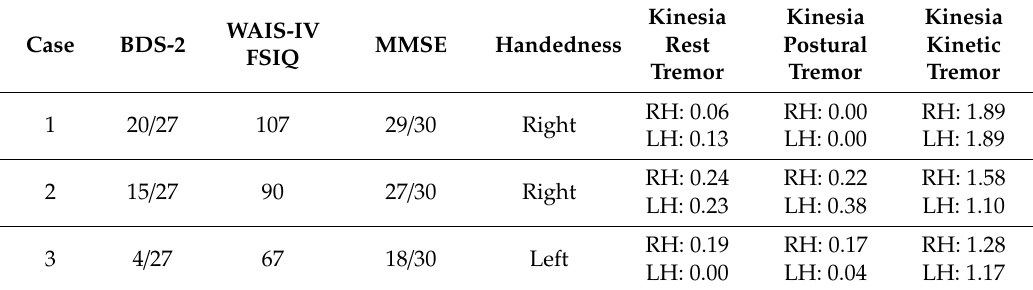
Table 2. Summary of cognitive and motor